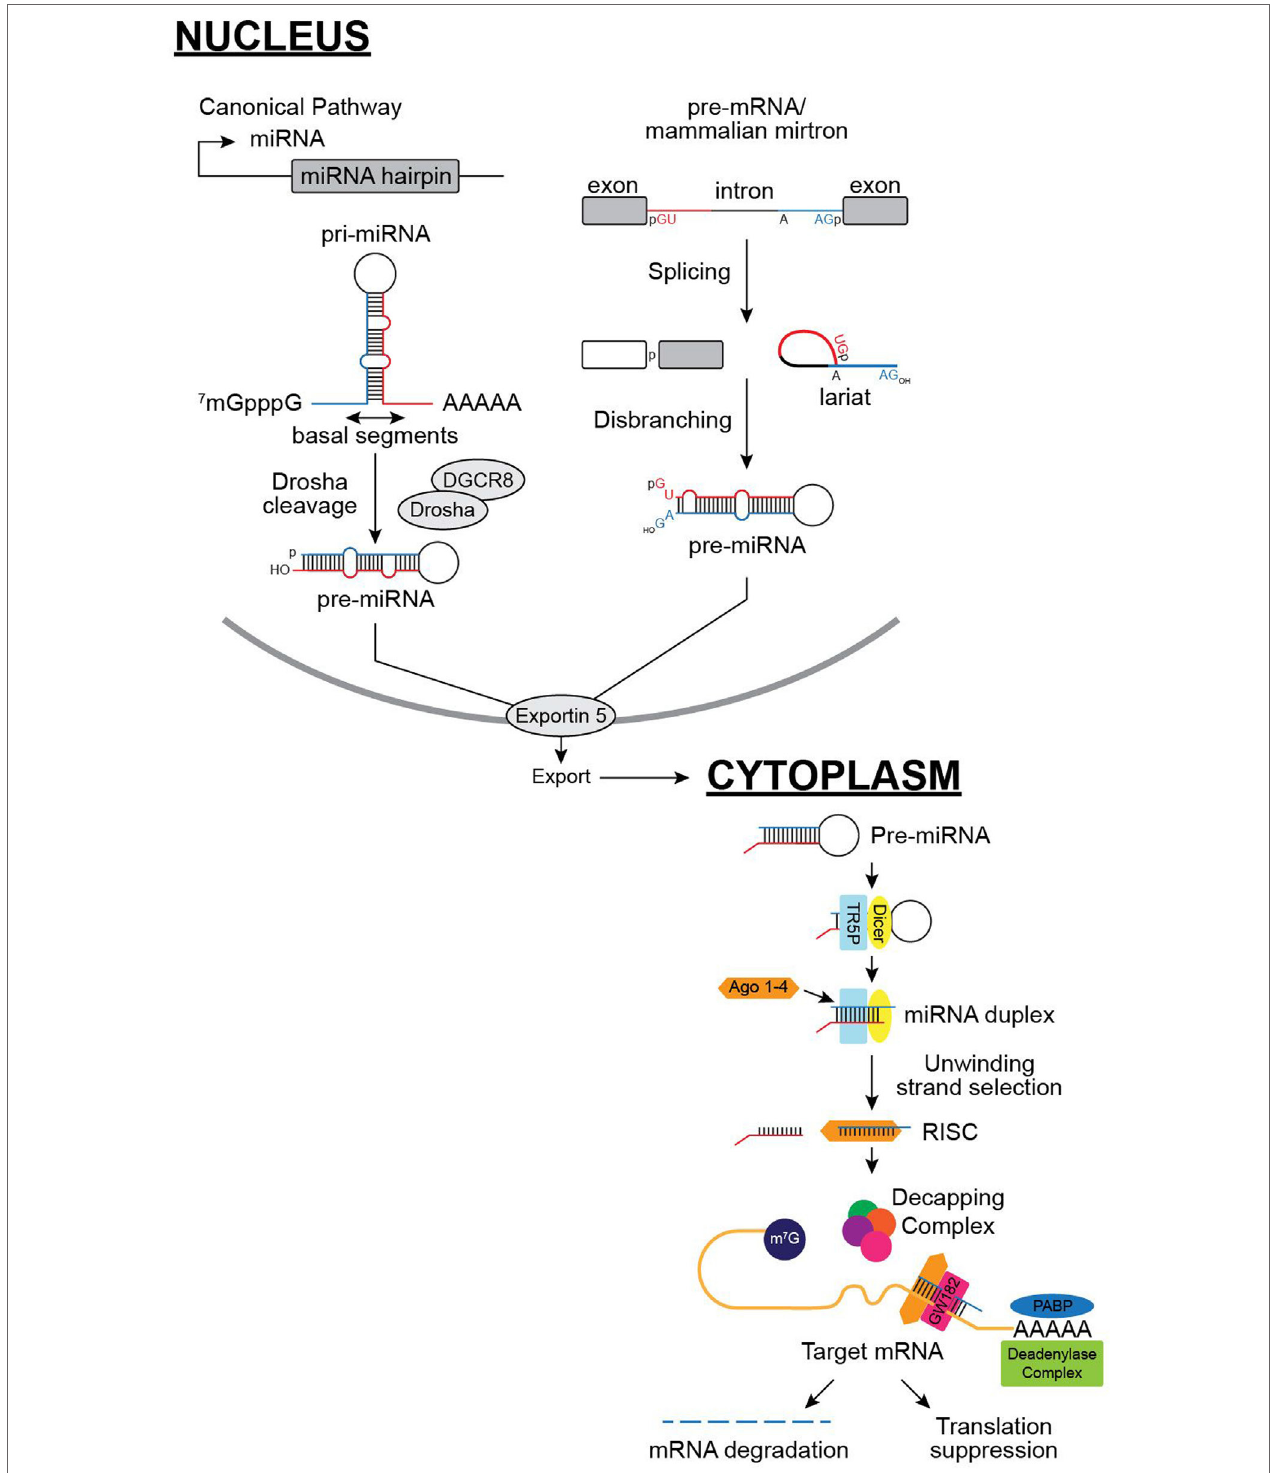
FiGURe 1 | MicroRNA (miRNA) biogenesis pathways: in the canonical pathway, miRNAs are first transcribed by RNA polymerase II in the nucleus that generates a primary miRNA (pri-miRNA), which are then processed by the Drosha–DGCR8 complex to produce precursor miRNAs (pre-miRNAs). Pre-miRNAs are then transported via exportin 5 into the cytoplasm, and are processed by Dicer-TRBP and loaded into AGO2-RISCs to downregulate target gene expression. GW182 (shown here) binds to PABP and prevents circularization of mRNA and promotes rapid degradation. miRNAs are also produced though non-canonical pathways (shown in the right), such as spliceosome-dependent mechanisms, without Drosha cleavage as shown here.